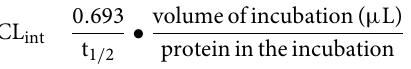
43% yield; (C) 3N HCl, dioxane, r.t., 48h, quantitative yield; (D) 4-cyanophenylmethylamine or 4-trifuoromethylphenylmethylamine, 1,1’-carbonyldimidazole, anhydrous THF, r.t., overnight, 95%